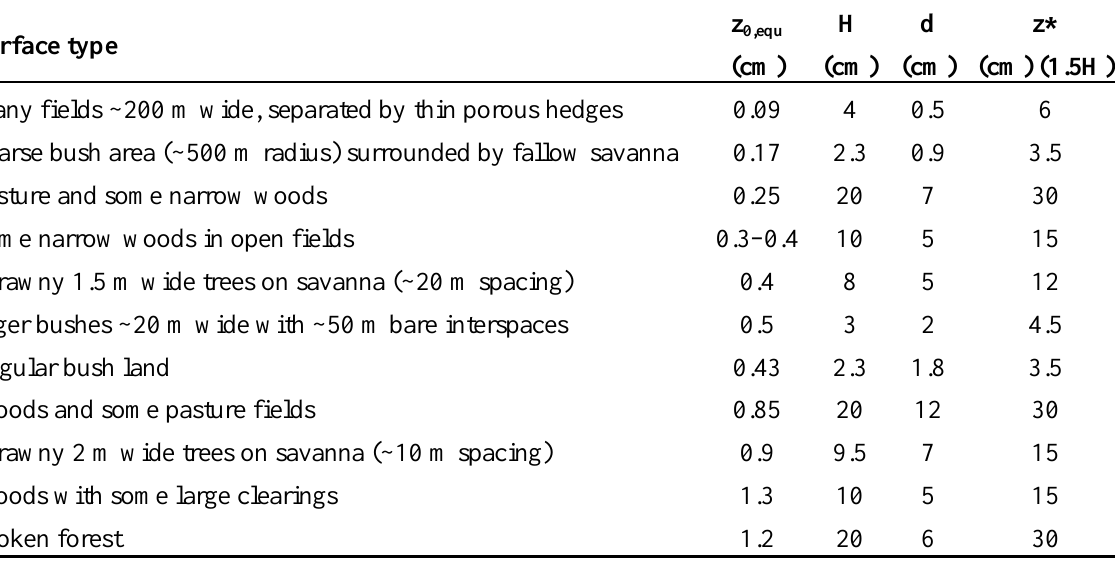
Table 2. Roughness parameters for heterogeneous terrain classes